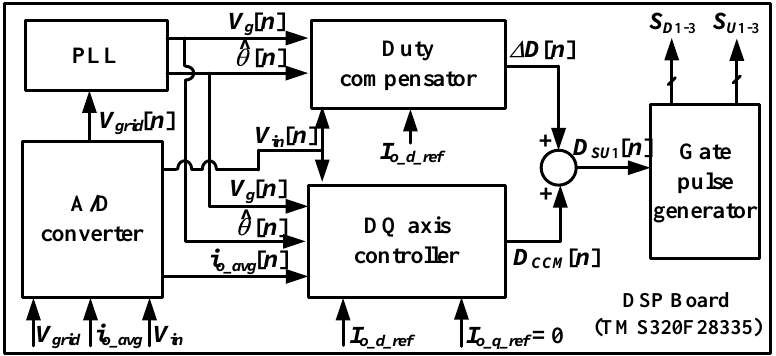
Figure 5. Block diagram of the control circuit for the proposed inverter.